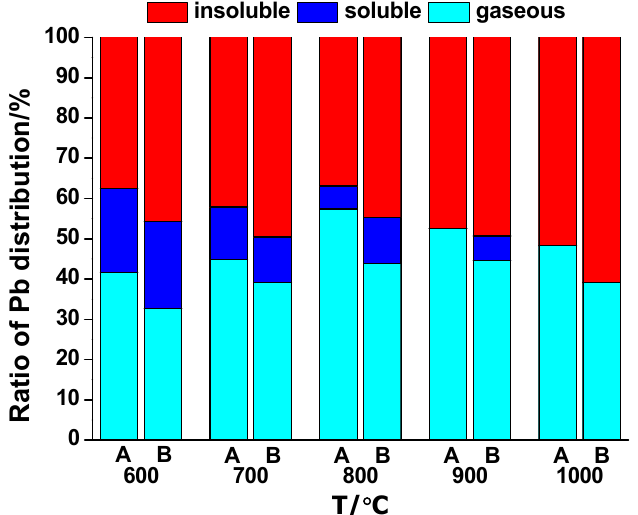
Figure 5. Distribution of Pb in the case of: ( A ) sludge combustion; ( B ) co-combustion.